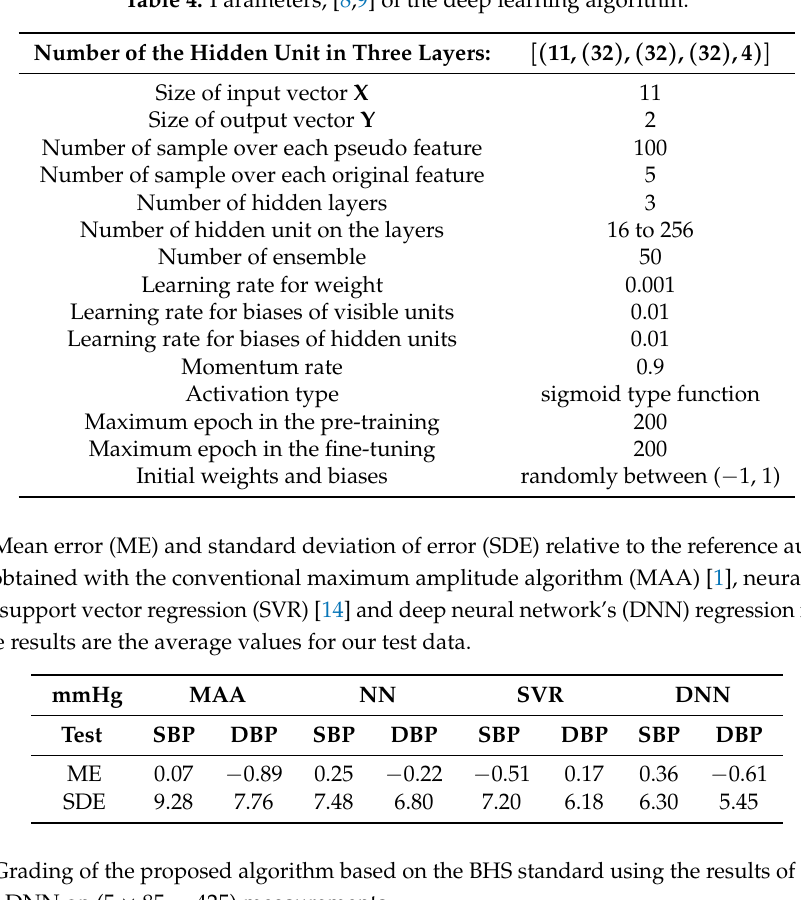
Table 4. Parameters, [8,9] of the deep learning algorithm.